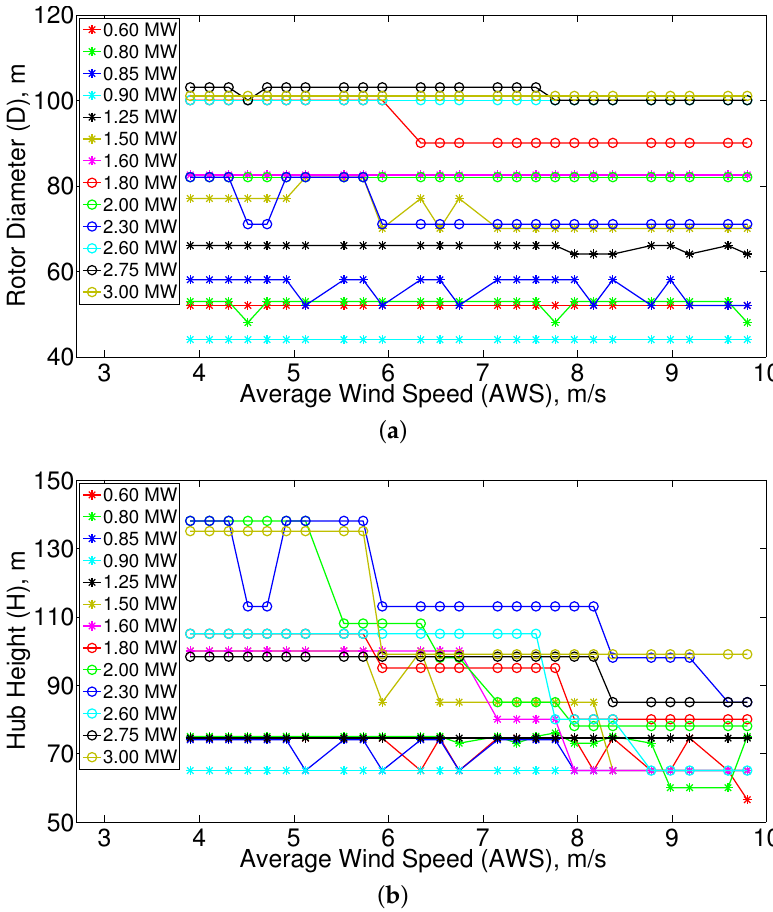
Figure 11. Features of the best performing turbines (of each rated-power class) for different AWS. ( a ) Turbine rotor diameter; ( b ) turbine hub